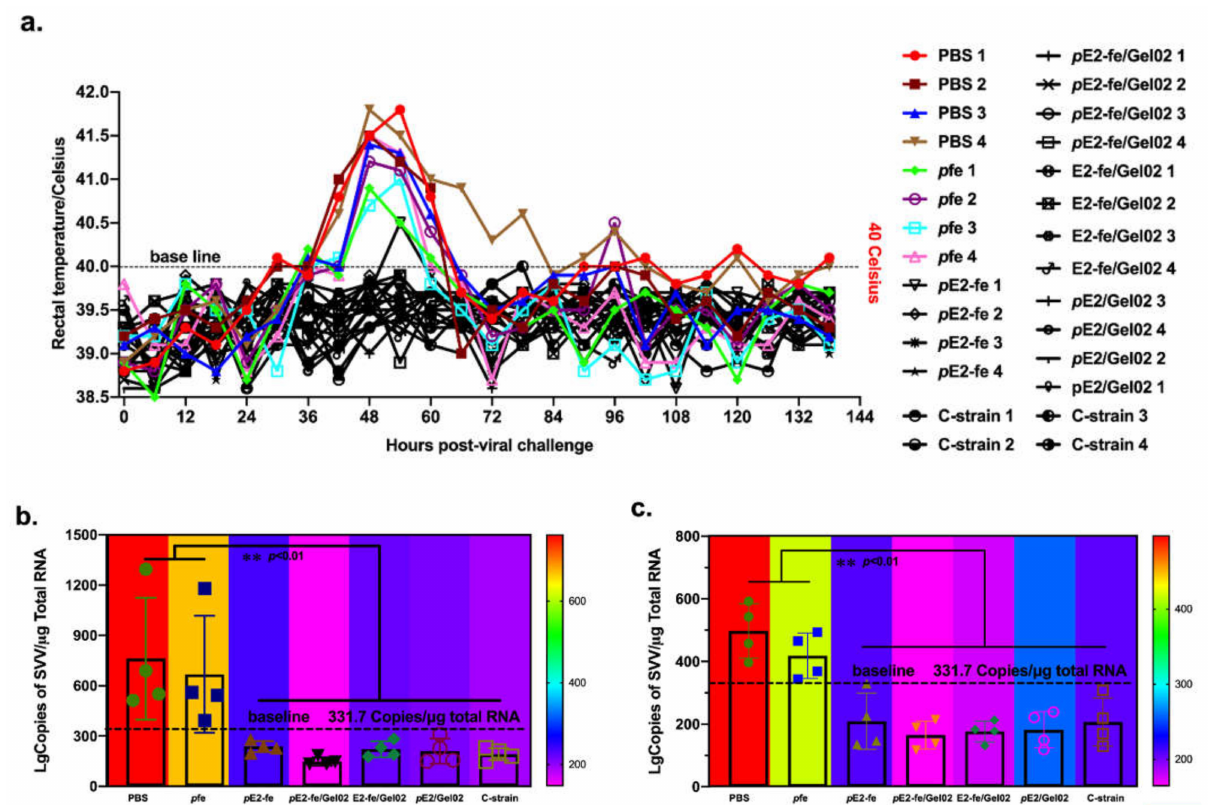
Figure 5. CSFV-specific stereotyped thermal response in ATR and viral tissue loading analysis. ( a ) Rectal temperature measurement and rabbits’ stereotyped thermal response identification post viral challenge. ( b ) CSFV viral tissue load analysis in spleen via absolute RT-qPCR. ( c ) Viremia analysis via absolute RT-qPCR. All the data showed in this Figure 5b,c are repeated 4 times. The data presented here were analyzed by two-way ANOVA assay using GraphPad Prism 8.0. **, 0.01 < p <